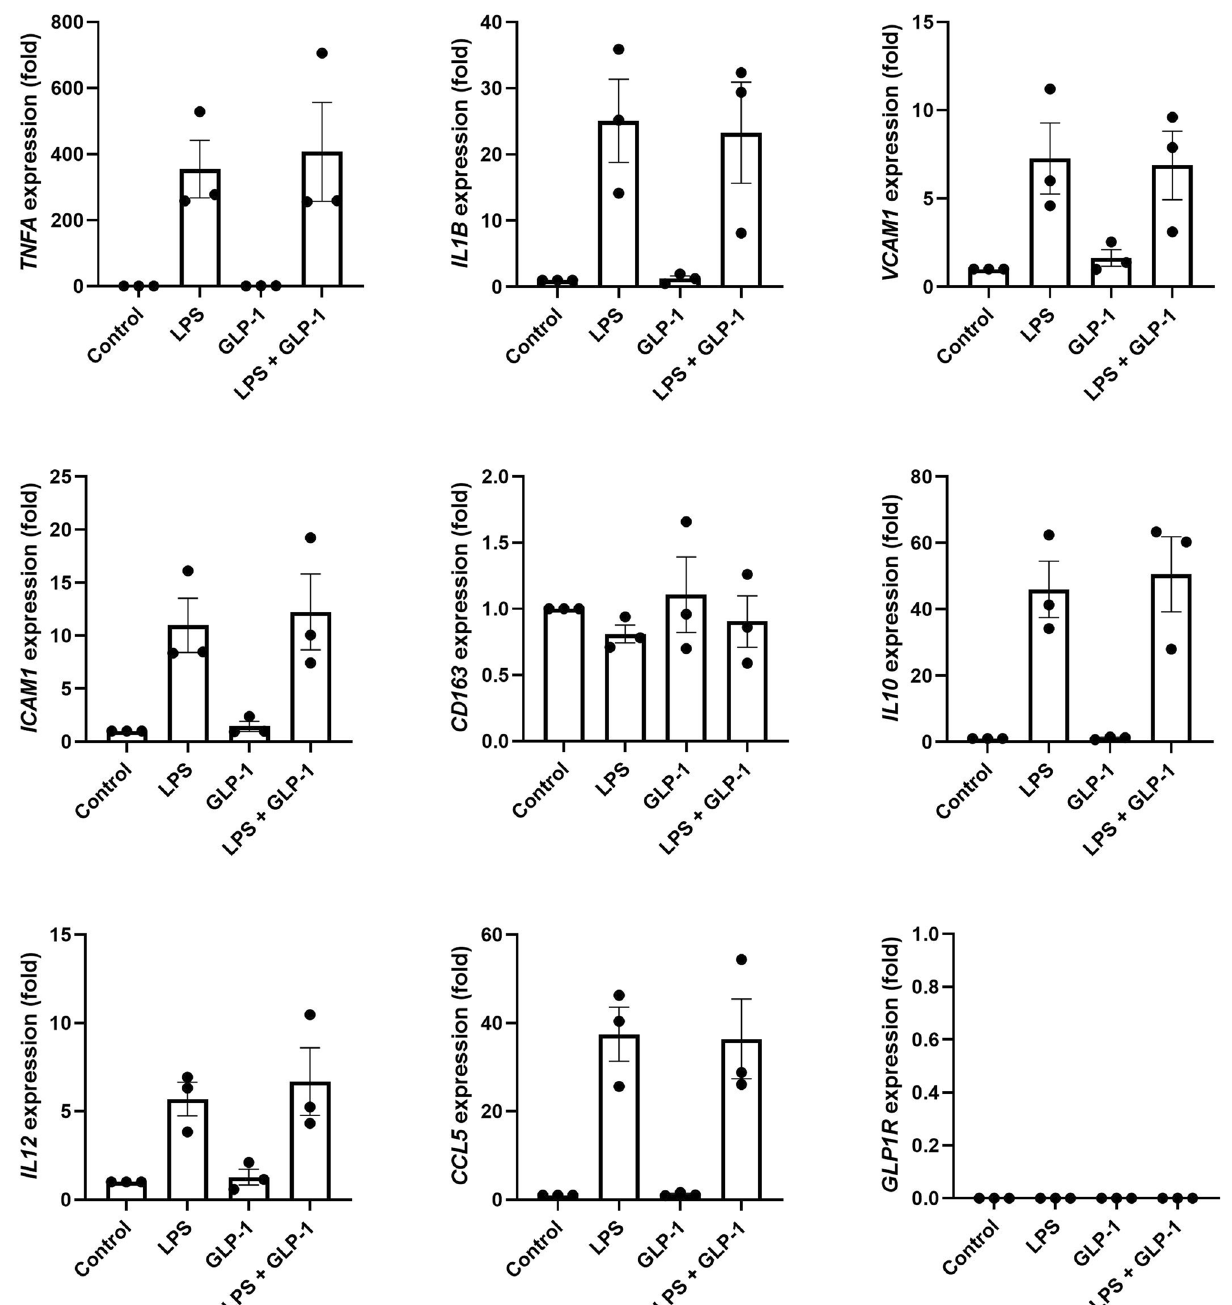
Figure 2. Effects of GLP-1 on the expression of inflammatory genes in human THP-1 cells. THP-1 cells were left untreated or exposed to 5 ng/ml LPS for 3 h in the presence or absence of 2.5 nM GLP-1. The expression of selected inflammatory genes and GLP1R was determined by real-time PCR. Gene expression was normalized to that of a housekeeping gene ( ACTB ) and data are presented as means ± SEM of 3 individual experiments. GLP- 1 glucagon-like peptide 1, LPS